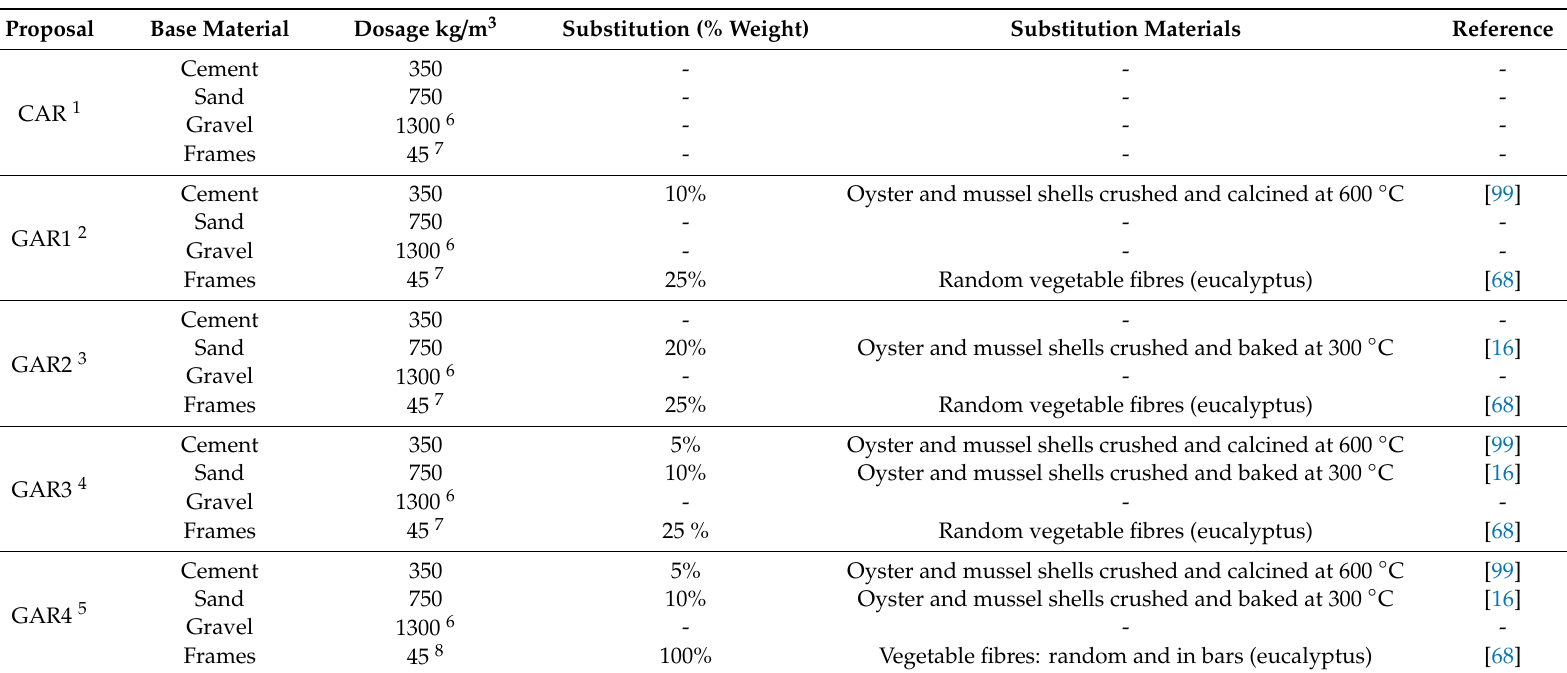
Table 4. Proposals analysed in the present work. Materials with percentage substitution and reference.